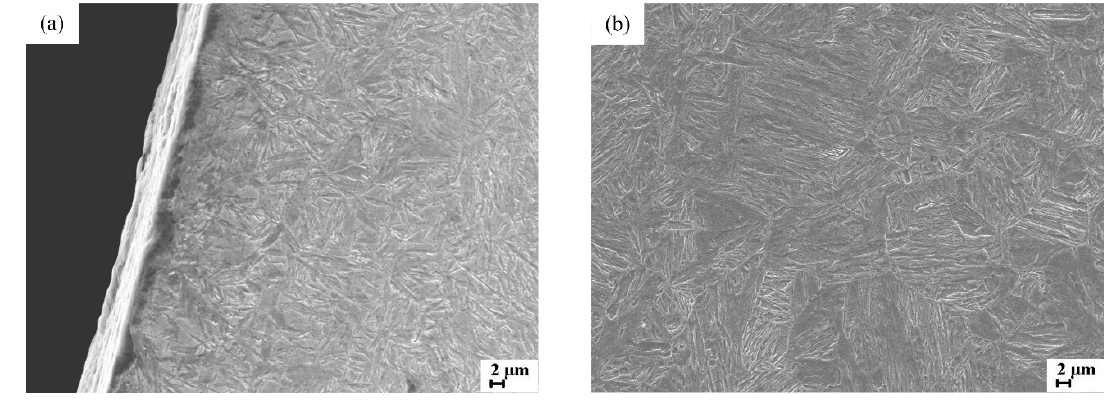
Figure 18. Microstructure of the tooth flank and core of gear 1 ‐ 2: ( a ) surface and ( b ) core.